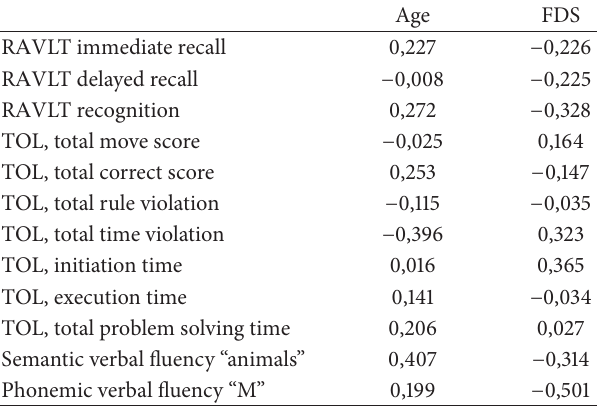
Table 4: Correlation coefficients between age, FDS, measuring severity of motor impairment, and the results from the neuropsy- chological tests in CCFDN